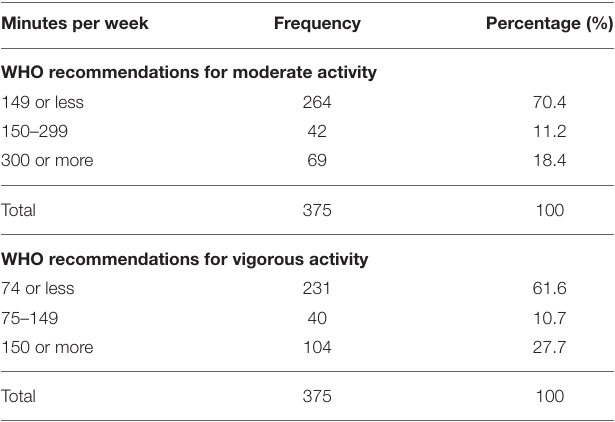
TABLE 5 | Proportion of participants achieving WHO recommendations for moderate and vigorous physical activity.